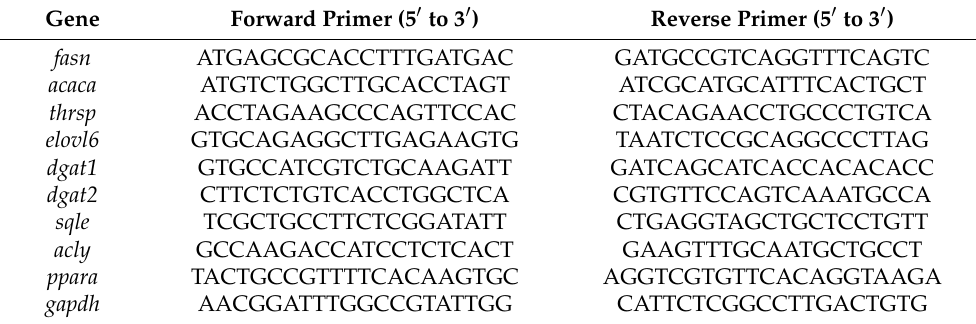
Table 1. Primers of qRT-PCR.